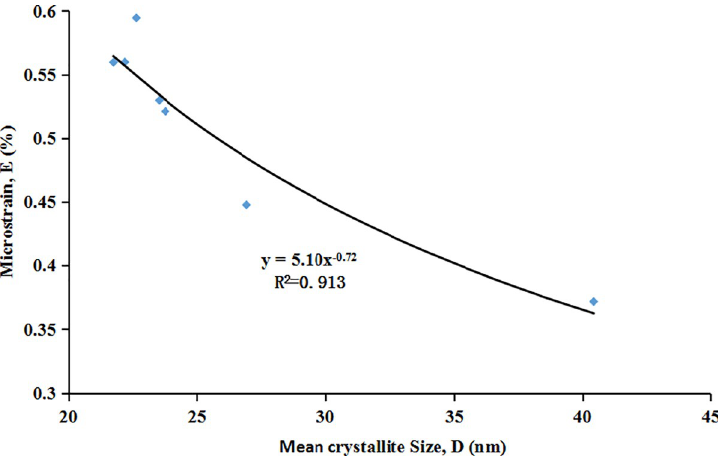
Fig 6. Correlation between mean crystallite size, (D) and microstrain, (E) in apatite.